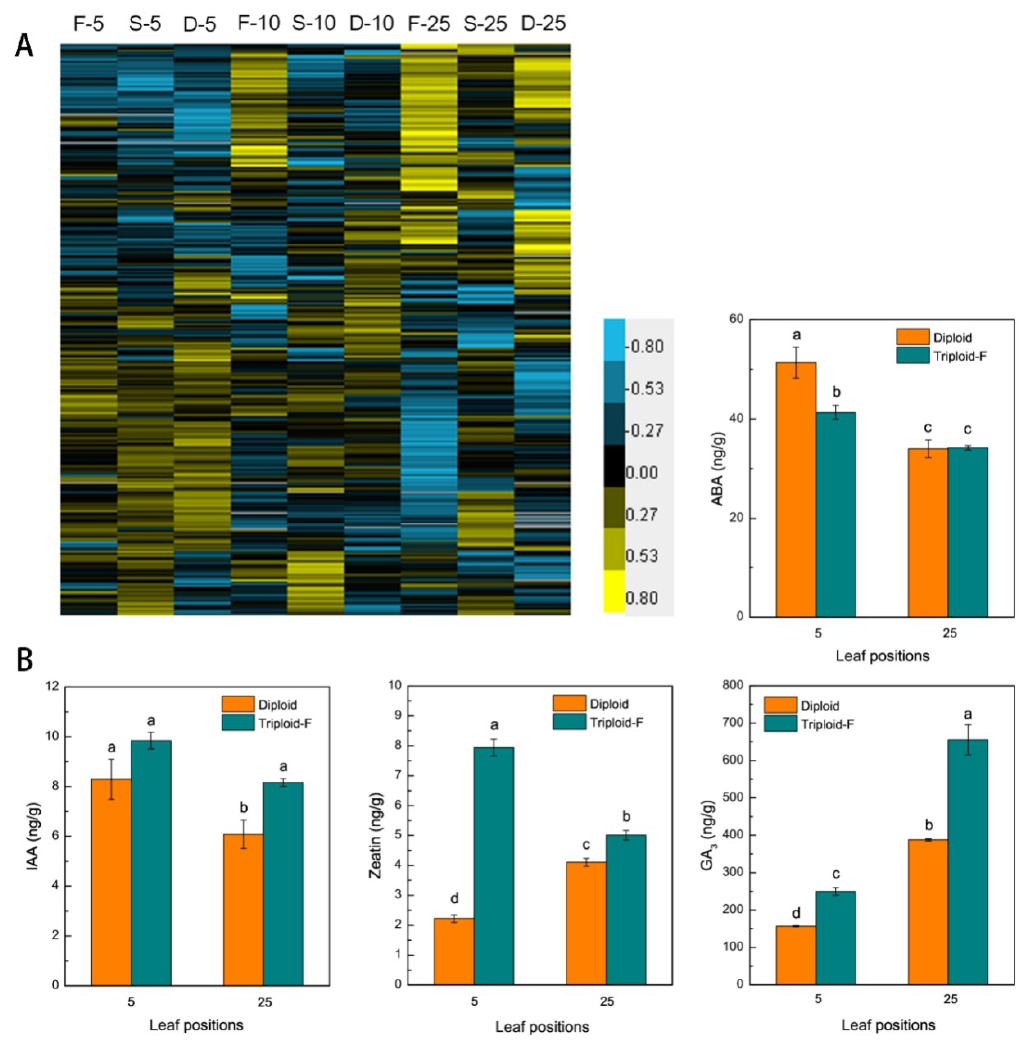
Figure 5. Hormone biosynthesis genes causing the upregulation of hormone in triploids. ( A ) Di ff erentially expressed genes (DEGs) involved in plant hormone signal transduction on di ff erent leaf canopy positions when triploid-F and triploid-S plants were compared to diploid plants; ( B ) IAA, ZT, GA3 and ABA content in the 5th and 25th leaves of triploid-F and diploid plants. Di ff erent lowercase letters represent significant di ff erences at p <